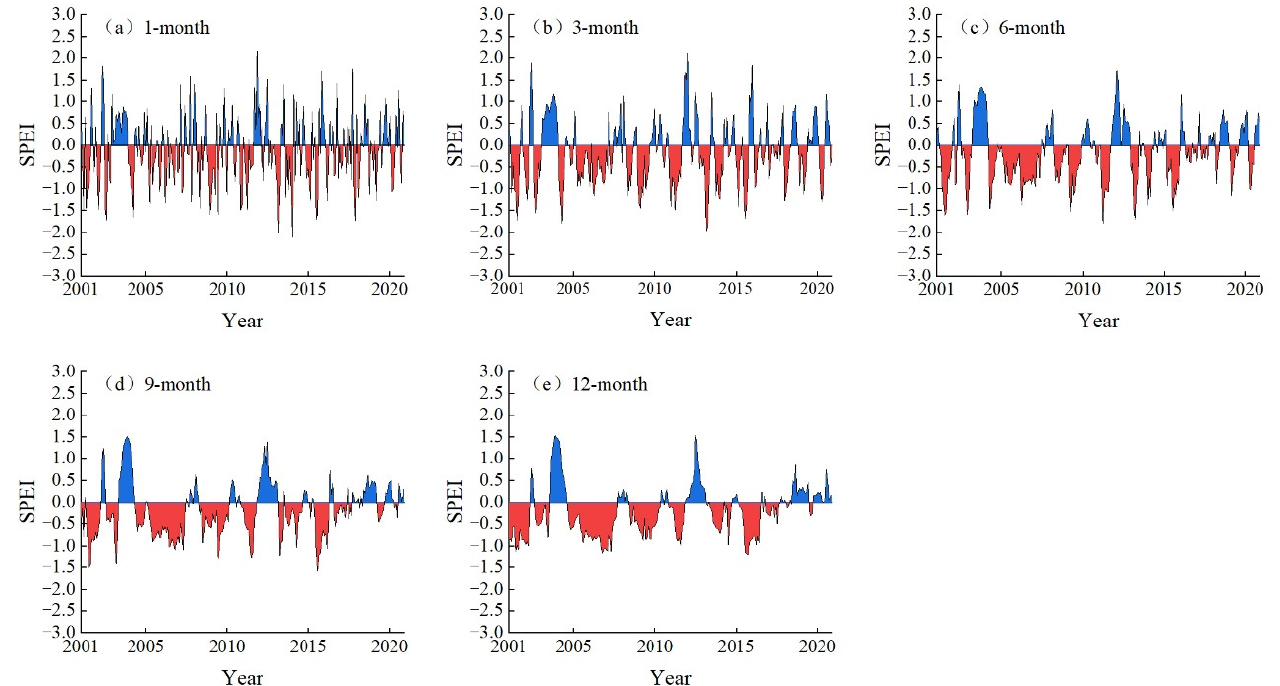
Figure 3. Temporal variation of meteorological drought at different time scales in YRB from 2001 to 2020. ( a ) SPEI-1; ( b ) SPEI-3; ( c ) SPEI-6; ( d ) SPEI-9; ( e ) SPEI-12. Using SPEI-3 and SPEI-12 to analyze the drought temporal variation characteristics of YRB in annual and different seasons, the results are shown in Figure 4. From 2001–2020, the annual SPEI has shown a gradually increasing trend at a rate of 0.0228/a. The fluctuations in the early stage of the year are violent, and the fluctuations in the later stage tend to be stable. SPEI showed a linear downward trend ( − 0.2147/a, R 2 = 0.0171) in spring. The fluctuation range was large before 2010 and had a small amplitude after 2010, indicating that YRB showed a gradually drought trend in spring (Figure 4b). SPEI showed an increasing trend in summer and autumn (Figure 4c,d), with an upward rate of 0.0442/a and 0.0061/a respectively. However, the overall fluctuation range in summer is large, and the regularity is not obvious. SPEI in summer reached its minimum in 2015. The rising rate in summer is significantly higher than that in annual, spring, and autumn, indicating that summer presents a wetting trend, which may be related to more rainfall in